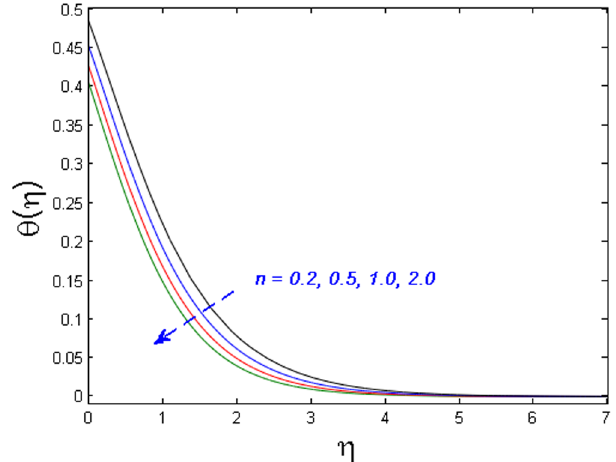
Figure 13. Effect of n on θ ( η ).